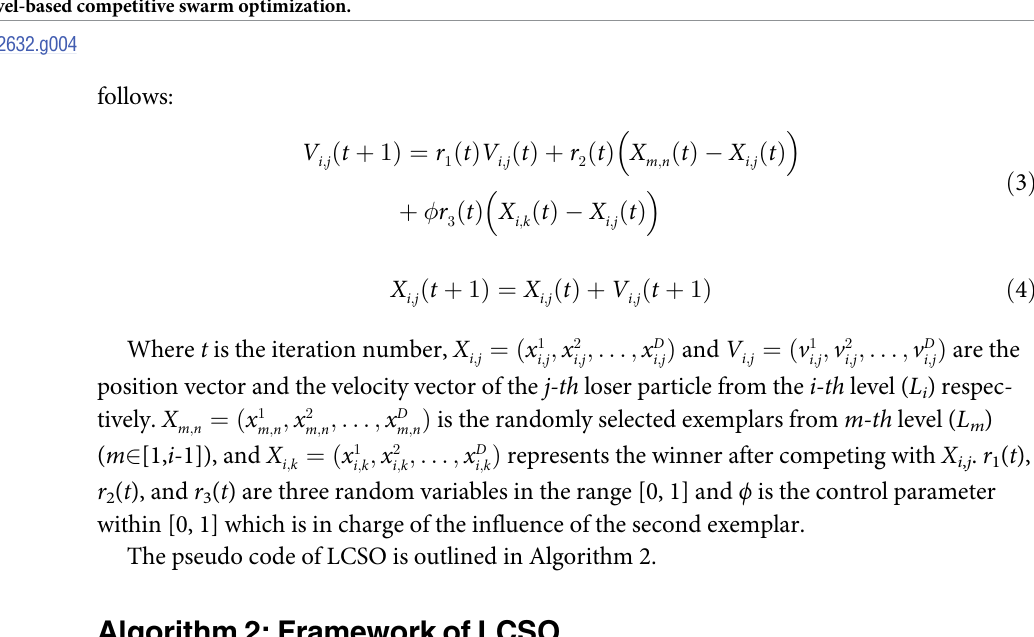
Fig 4. Framework of the proposed level-based competitive swarm